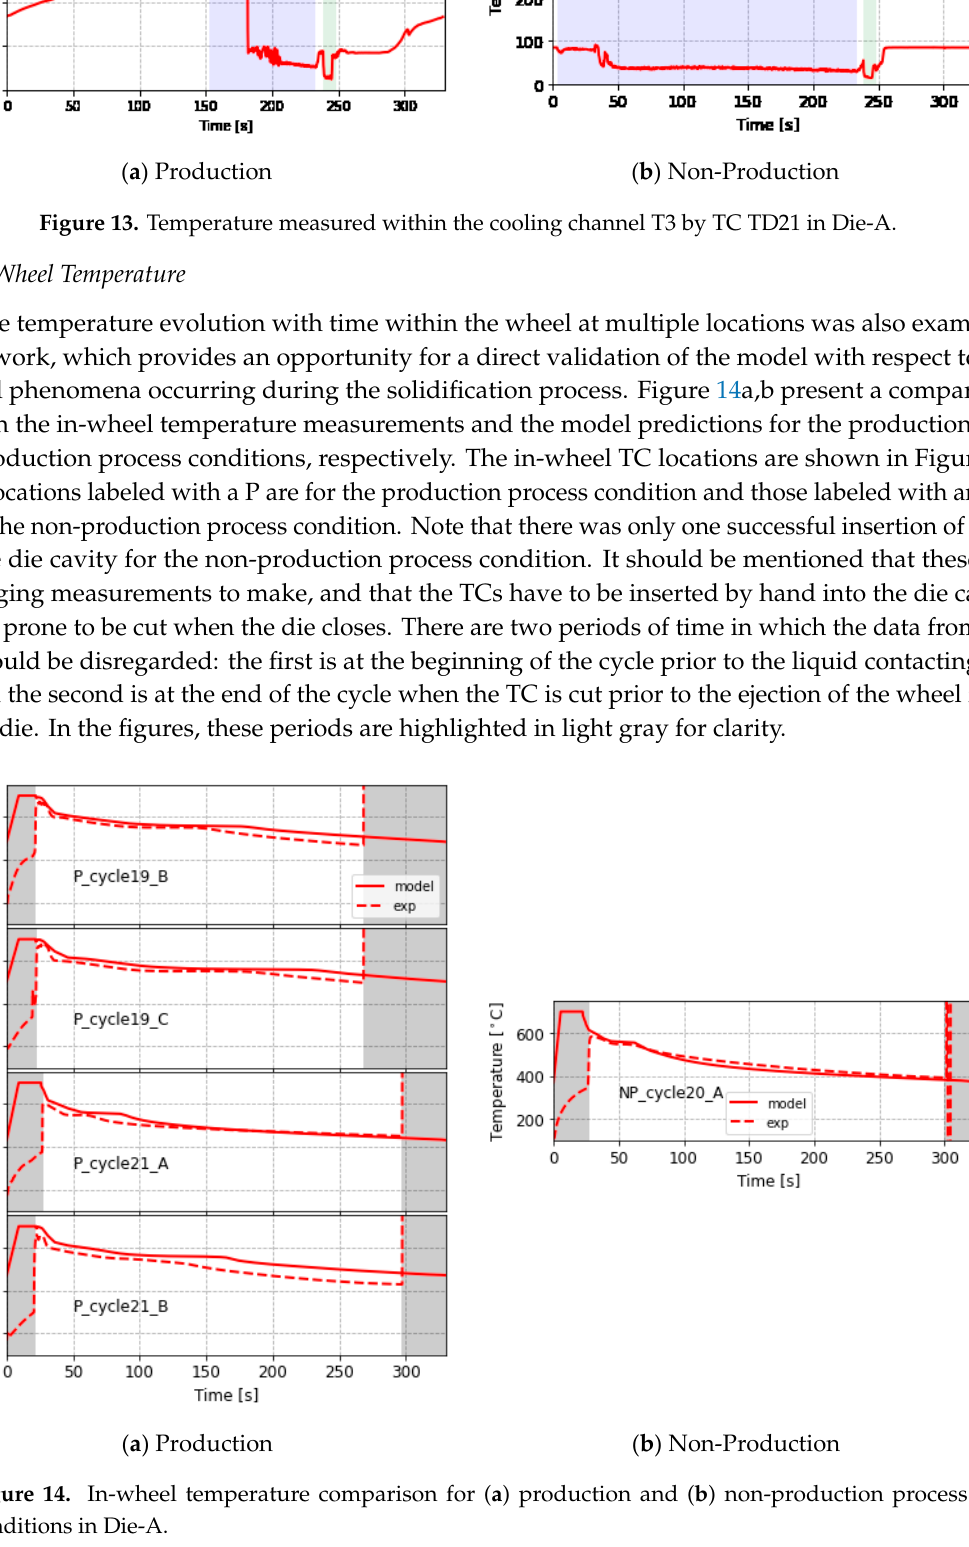
Figure 15. Cast-in TC locations in wheels produced with Die-A. From the comparison, it can be seen that, overall, the model-predicted in-wheel temperatures follow the profiles of the measured data relatively well. The poorest agreement is observed for locations P_cycle21B and P_cycle19B, both of which are located in the spoke near the rim–spoke junction. In P_cycle21B, the error is approximately 50 °C at the end of the cycle. As can be seen, the model and experimental data both reflect the latent heat release associated with primary α -aluminum solidification at approximately ~600 °C and eutectic formation at ~560 °C, as evidenced by periods of reduced rates in temperature decline—see reference for solidification sequence [19]. 3.3. Solidification Direction The solidification path predicted by the model has been used to assess the locations that would be prone to form porosities. The solidification front should ideally follow a path that continuously provides access to liquid to offset the density increase associated with the liquid-to-solid transformation. The failure to achieve this condition may lead to the formation of regions containing